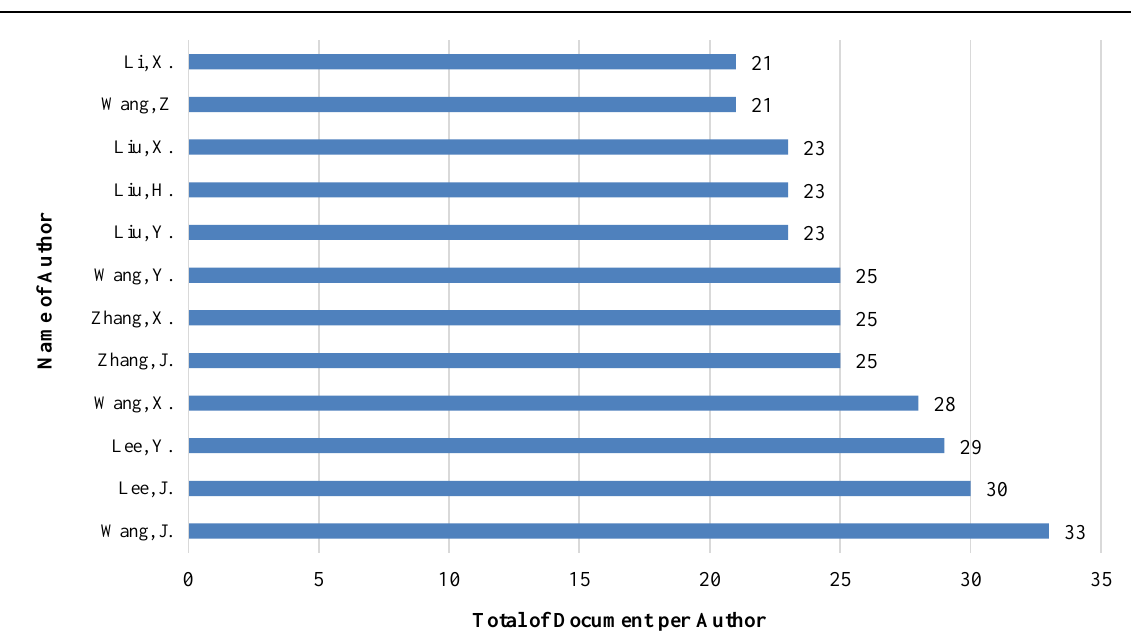
Figure 2. Authors producing most theory related